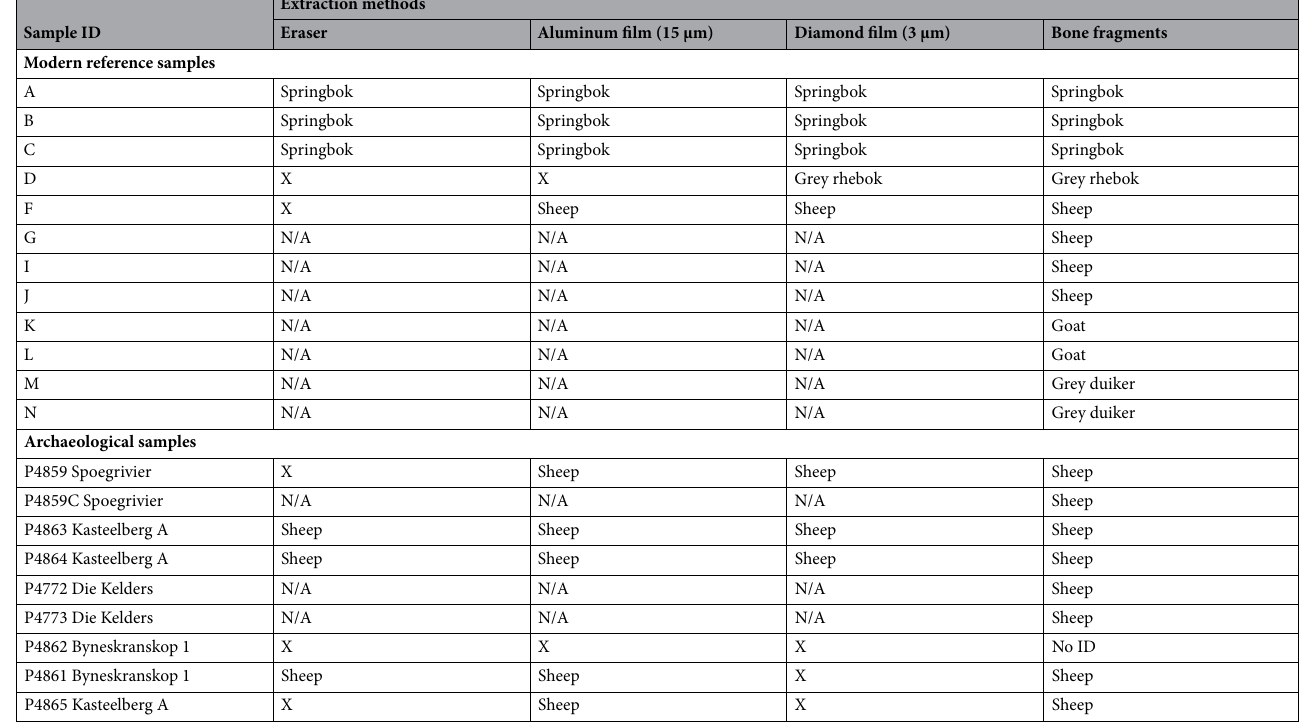
Table 2. Species identification of modern reference and archaeological samples using different extraction methods. X indicates that minimally destructive sampling (PVC eraser/polishing film) was attempted but failed to produce spectra good enough for identification, while N/A indicates that minimally destructive sampling was not